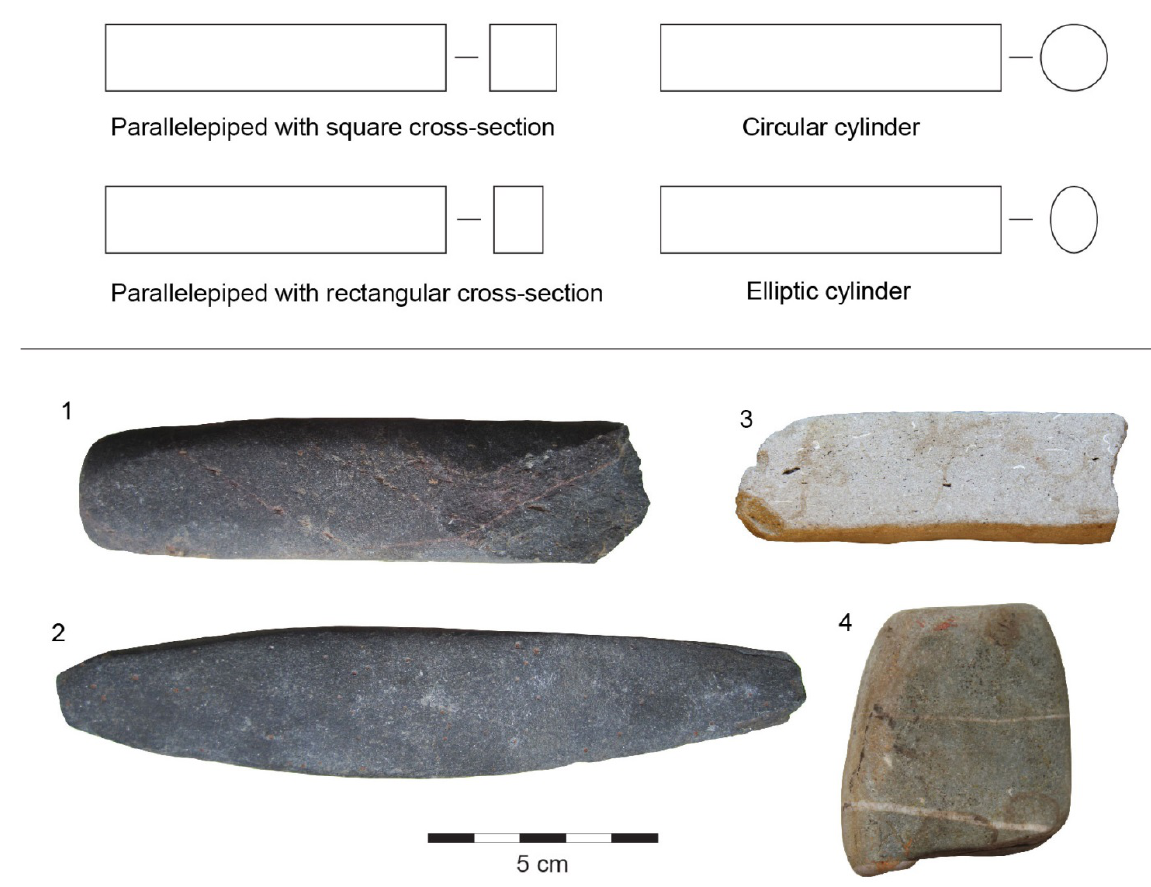
Figure 1. Simplified whetstone typology and examples of Gallo-Roman whetstones from Les Rues-des-Vignes, Department of Nord, France. 1 and 2. Cylindrical whetstones fashioned from (1) blackish siltstone and (2) dark grey fine-grained sandstone (Petite-Commune Formation, Revin group, Lower Palaeozoic); 3. Parallelepiped whetstone fashioned from pale grey calcite-cemented fossiliferous sandstone (Cretaceous, Upper Mesozoic); 4. Fluvial grey quartzite pebble (Cambrian or Lower Devonian, Palaeozoic) with white quartz veins (“natural”